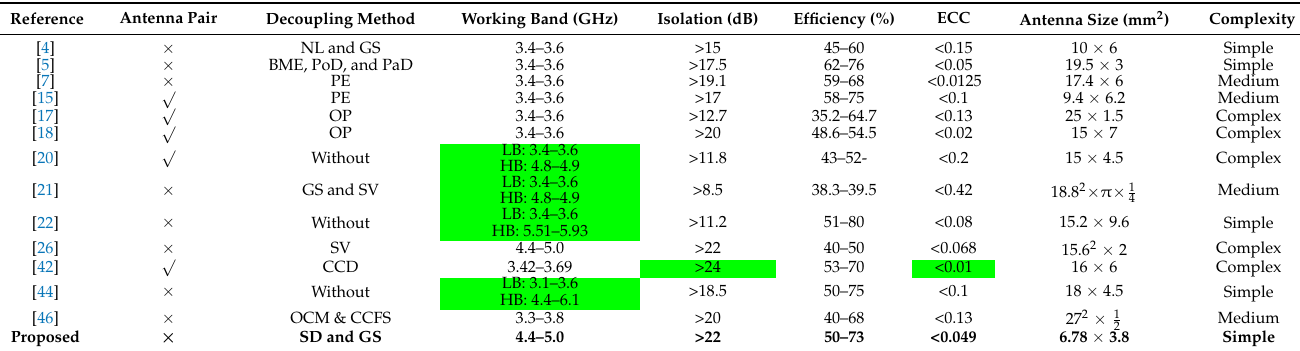
Table 1. Performance comparison of the 5G MIMO terminal